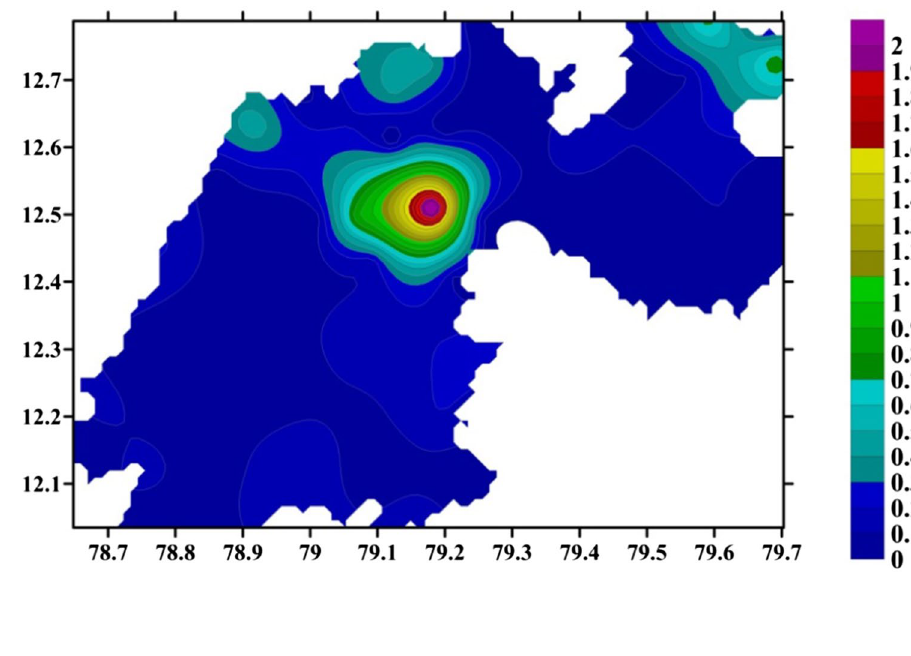
Fig. 16 Spatial distribution of LADD in the study area for adult